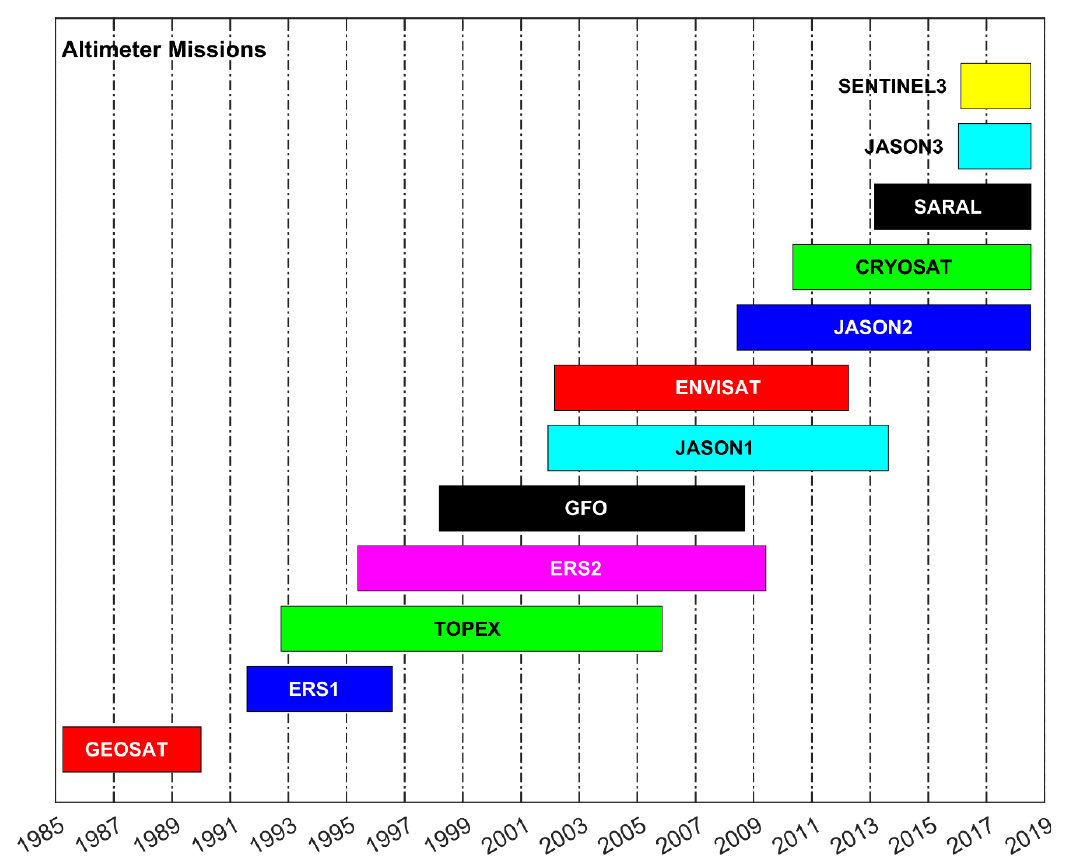
Figure 1. Altimeter missions used in the analysis. The duration of data available from each mission is shown [47,50].